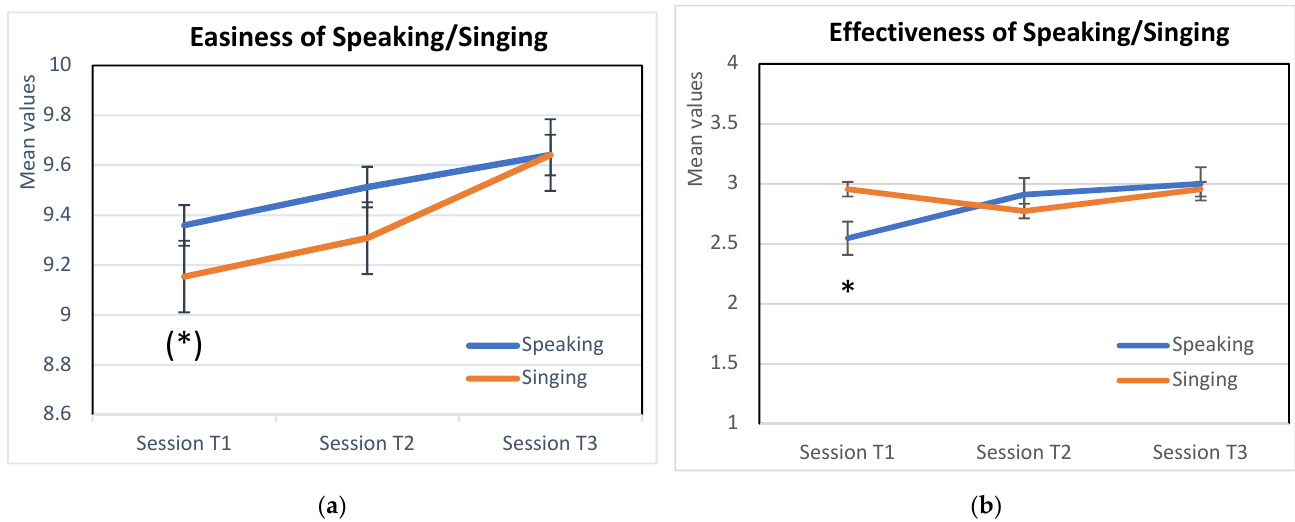
Figure 1. Mean values of ( a ) Perceived ease and ( b ) Perceived effectiveness of maternal speaking and singing to preterm infants in the NICU across the three sessions. * p < 0.05; (*) tendentially significant, p = 0.65.